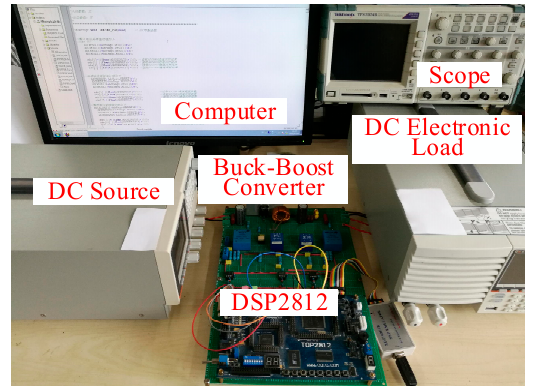
Figure 11. DSP2812-based principle prototype of the large-signal inverse-system decoupling control system for buck–boost converters.